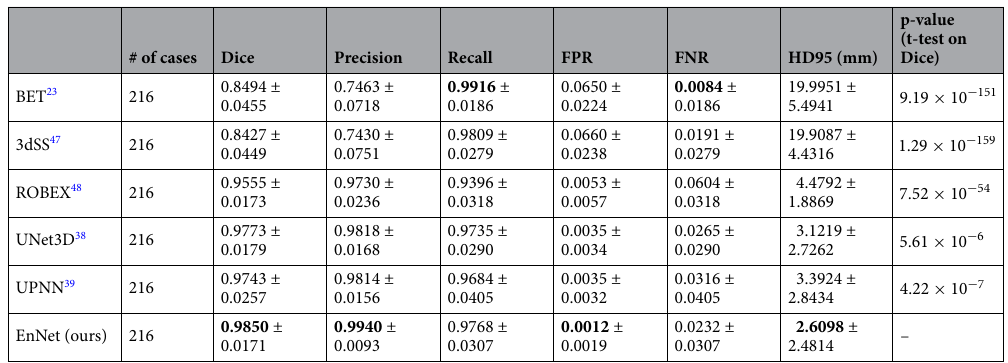
Table 5. Skull stripping performance comparison to state-of-the-arts. The best result is highlighted in